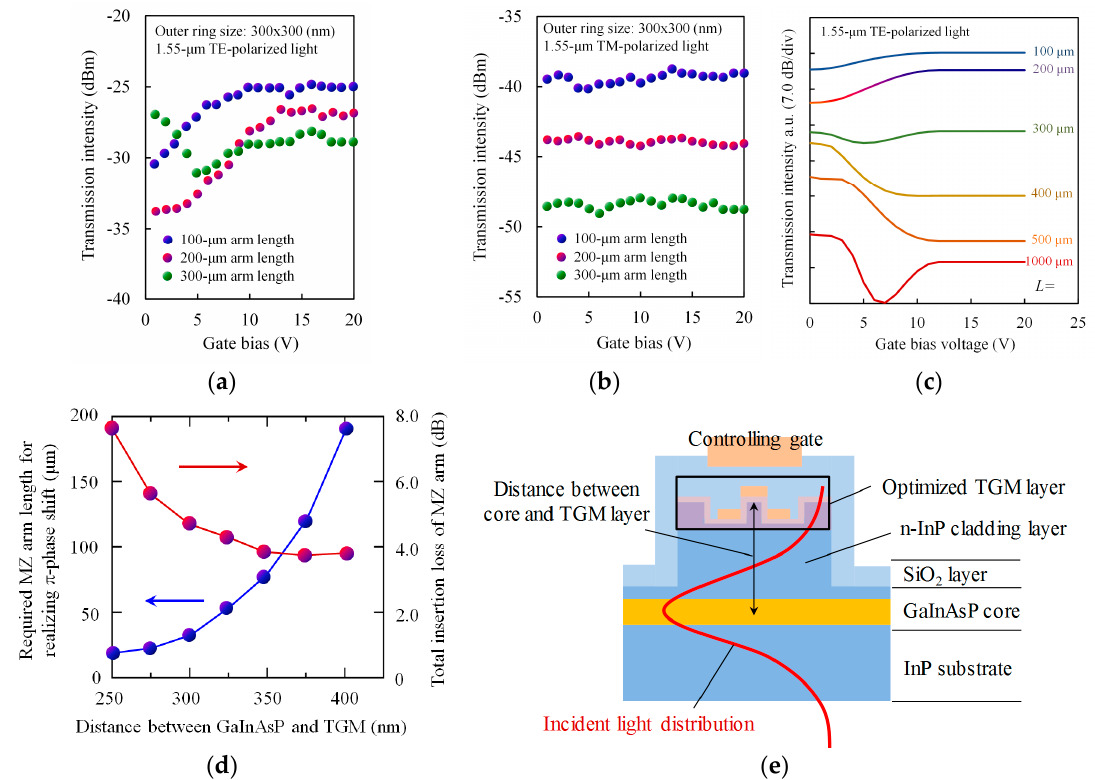
Figure 11. Transmission intensity of permeability-controlled modulator as a function of gate voltage; ( a ) Measured results for TE light; ( b ) measured for TM light; and ( c ) simulated transmission characteristics with TGM arm length as a parameter; ( d ) Simulated performance limit of permeability-controlled modulator; required MZ arm length for realizing π -phase shift together with a total insertion loss of the MZ arm as a function of the distance between the GaInAsP core and optimized TGM layer; ( e ) Schematic image of cross sectional image of